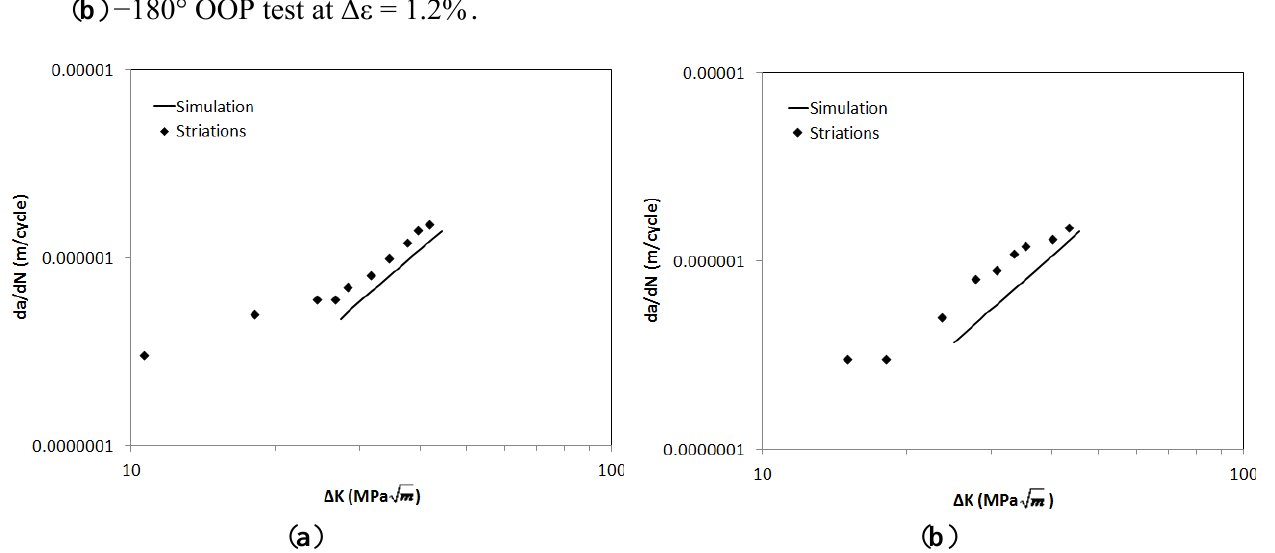
Figure 11. TMF crack propagation predictions for ( a ) −90° OOP test at Δε = 1%; ( b ) −180° OOP test at Δε =